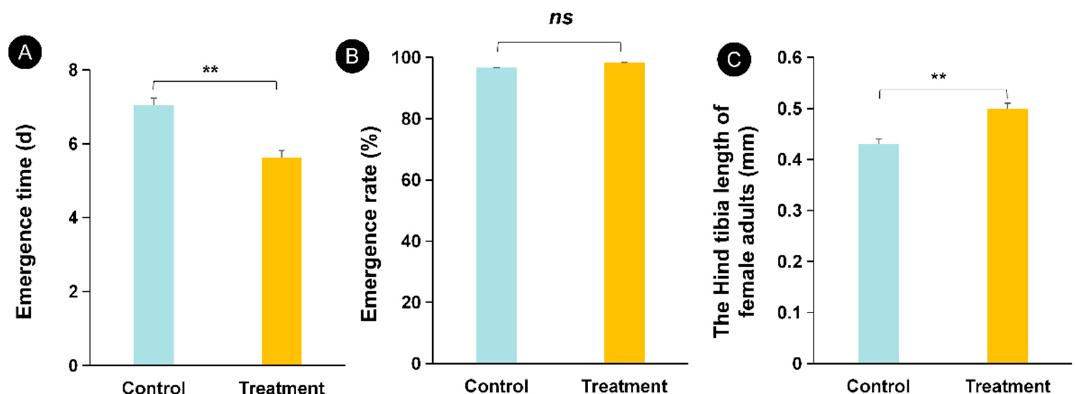
Figure 1. Effect of high temperature on pupal development ( A ) emergence rate ( B ) and the hind tibia of female adults ( C ) of Aenasius bambawalei . ** indicates that there is a significant difference between the high temperature treatment and the control.